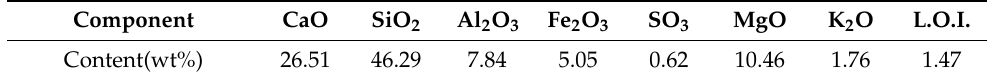
Table 3. Chemical compositions of slag.